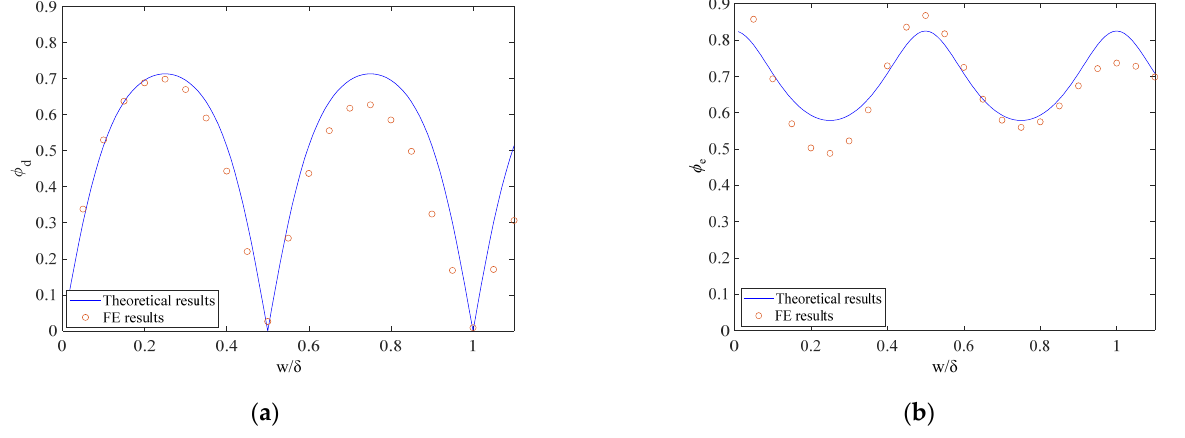
Figure 6. Influence of damage width on the reflections from ( a ) the damage and ( b ) the end predicted by theory and validated by finite element simulations.